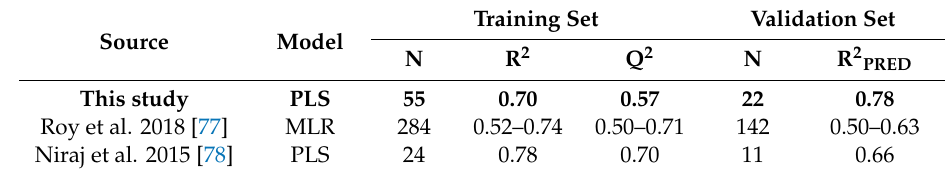
Table 4. Comparison of this study with previous published works on 2D-QSAR model for AChE. Source